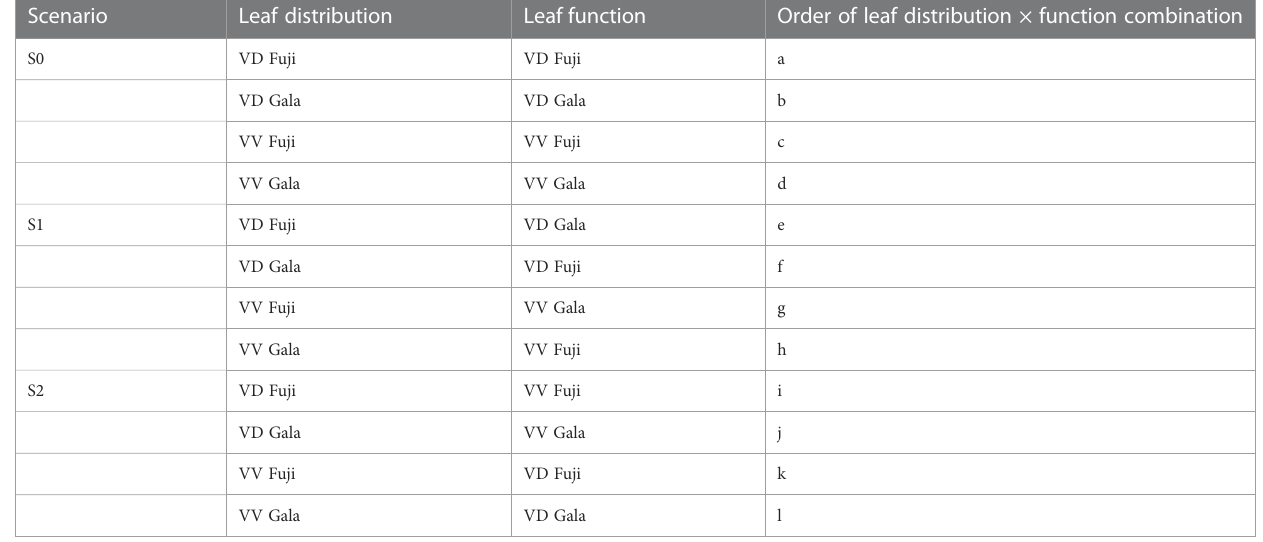
TABLE 1 Reference (S0) and switching scenarios (S1 and S2) obtained with the RATP model for ‘ Fuji ’ and ‘ Gala ’ apple trees grafted on vigorous rootstocks and associated with either a dwarf M26 interstock (VD) or a vigorous ‘ Qinguan ’ interstock (VV).